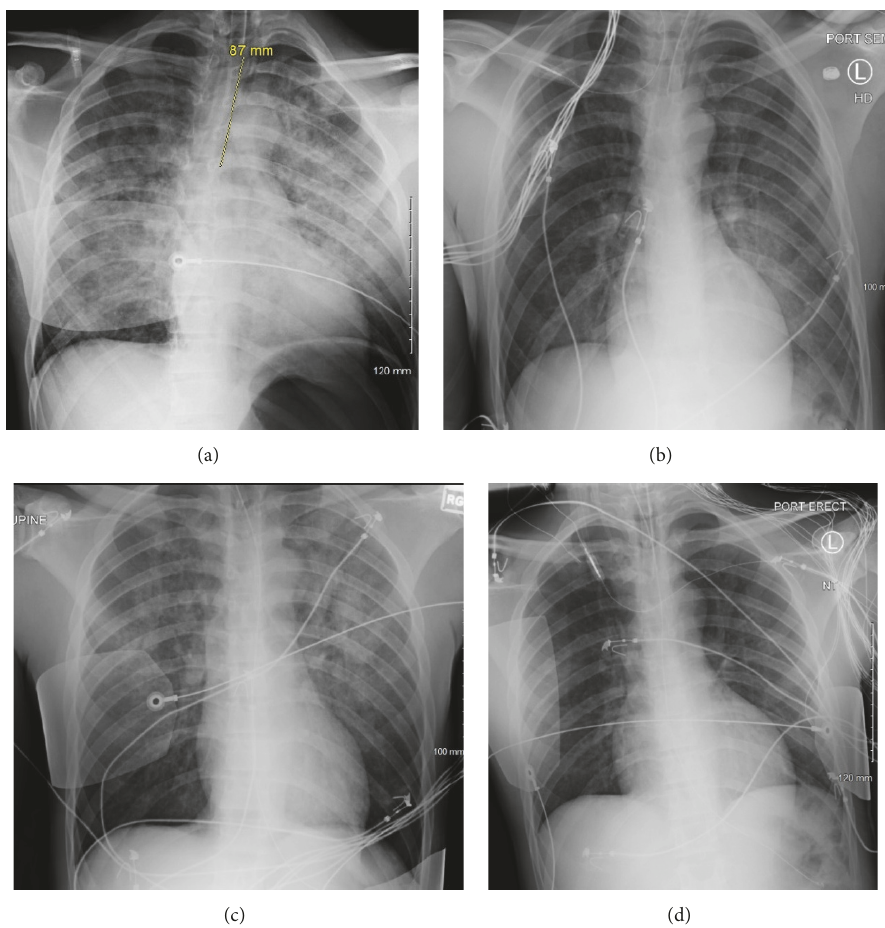
Figure 1: Chest radiographs from each admission. Initial postintubation radiograph (a) from his first admission showing diffuse bilateral infiltrates; repeat radiograph (b) showing resolution approximately 18 hours later. Initial radiograph (c) from the second admission again demonstrating bilateral opacities which resolved (d) within 48